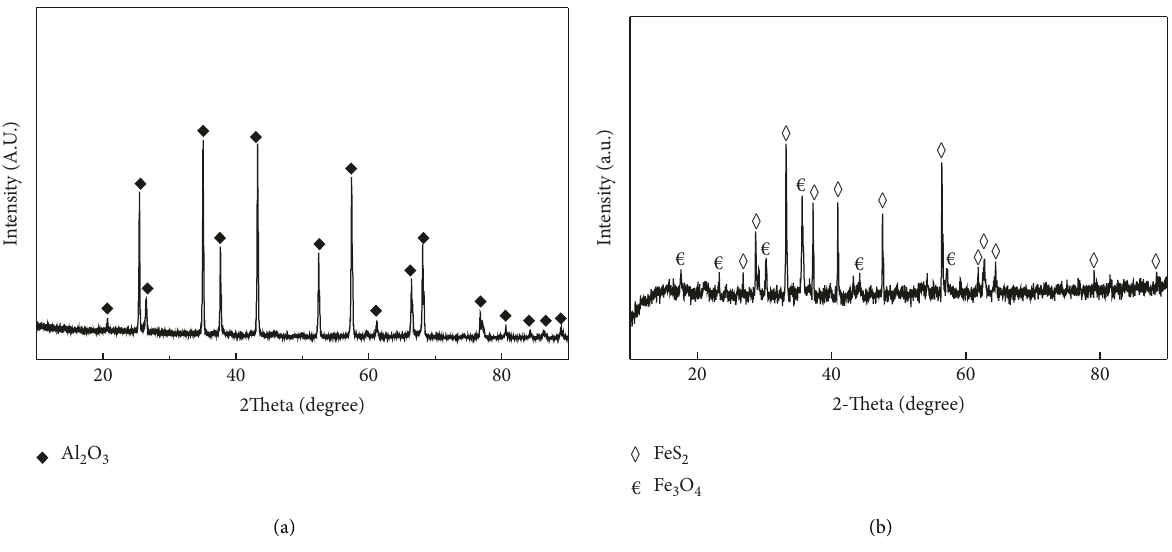
Figure 1: XRD pattern of (a) spent Al 2 O 3 carrier and (b) Pt/Re catalyst and